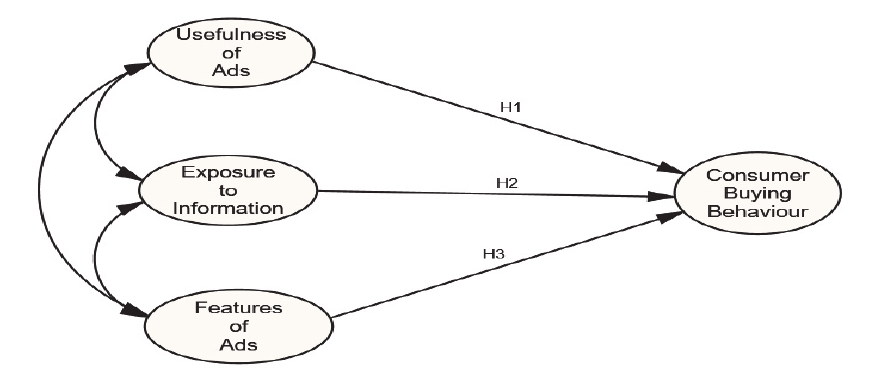
Fig. 1. Propose framework of the